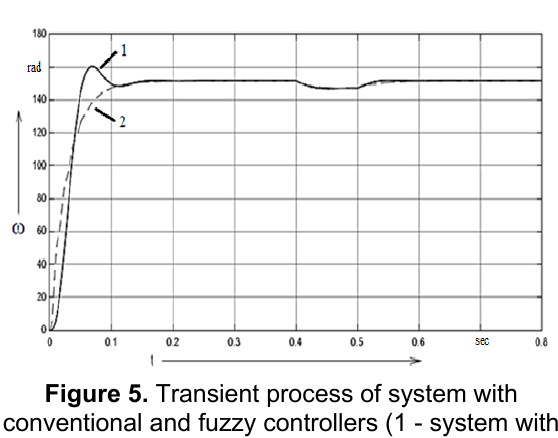
Figure 4. DC drive mode l with fuzzy controller